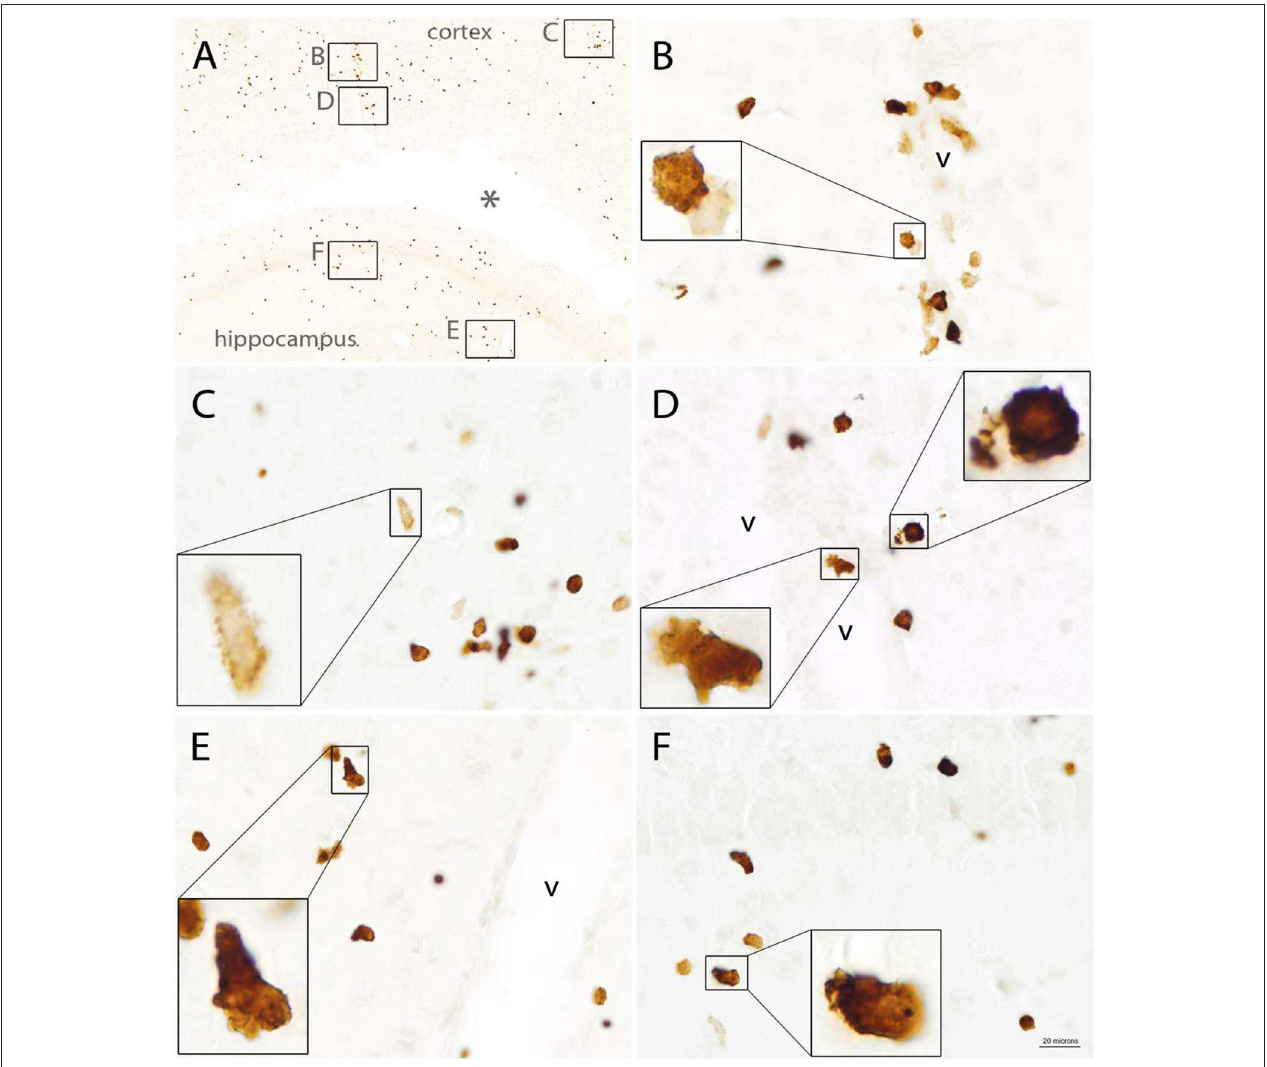
FIGURE 8 | Quin-IR in the vicinity of the injection site 3 days after intracerebral injection of LPS. Quin expression was maximal on day 3 after LPS injection. Immunoreactive cells exhibited highly variable morphology, including lamellipodia and filopodia. Membrane protrusions in the stained cells were very common, indicative of highly mobile cells. Quin-IR cells were scattered around the LPS-affected region (A) . Inset areas in (A) show magnified regions in (B – F) . Concentrated Quin-IR cells were observed around the vasculature (v) (B,D,E,F) . Some Quin-IR cells were stained at their periphery and had many membrane extensions (C) . *Necrotic region around injection site. Bar in (F) , 200 µ m in (A) , 20 µ m in (C–F) , and 5.5 µ m in